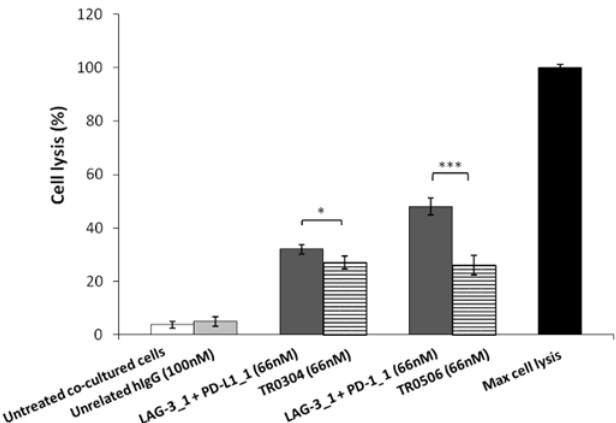
Figure 10. Cardiotoxic effects induced by immunomodulatory tribodies or the combination of their respective parental compounds on human fetal cardiomyocytes. The lysis of HFC cells, co-cultured with hPBMCs in the absence (white bars) or presence of tribodies (striped bars) or the combinations of their respective compounds (grey bars) for 24 h, was analyzed by measuring the release of LDH in the supernatants of cultures. The values are reported as the mean of at least three determinations obtained in three independent experiments. Error bars depict means ± SD. p -value: *** p ≤ 0.001; * p < 0.05.